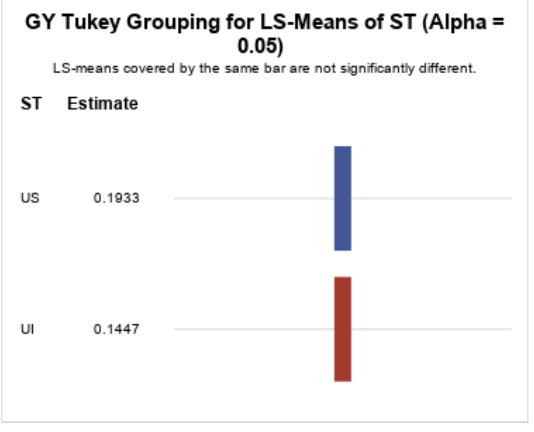
Figure 3. Least square differences of the treatment.